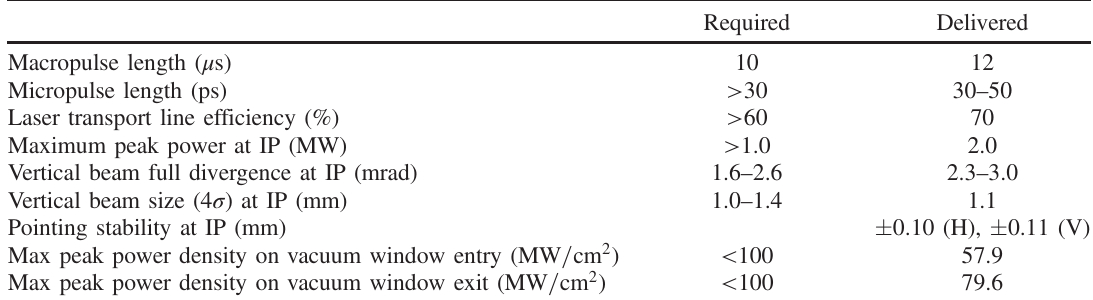
TABLE II. Table of required versus achieved laser system